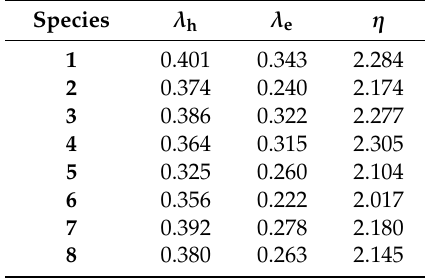
Table 5. Calculated λ e , λ h , and η values (all in eV) of 1 – 8 at the PBE0 / 6-31G (d,p) level.